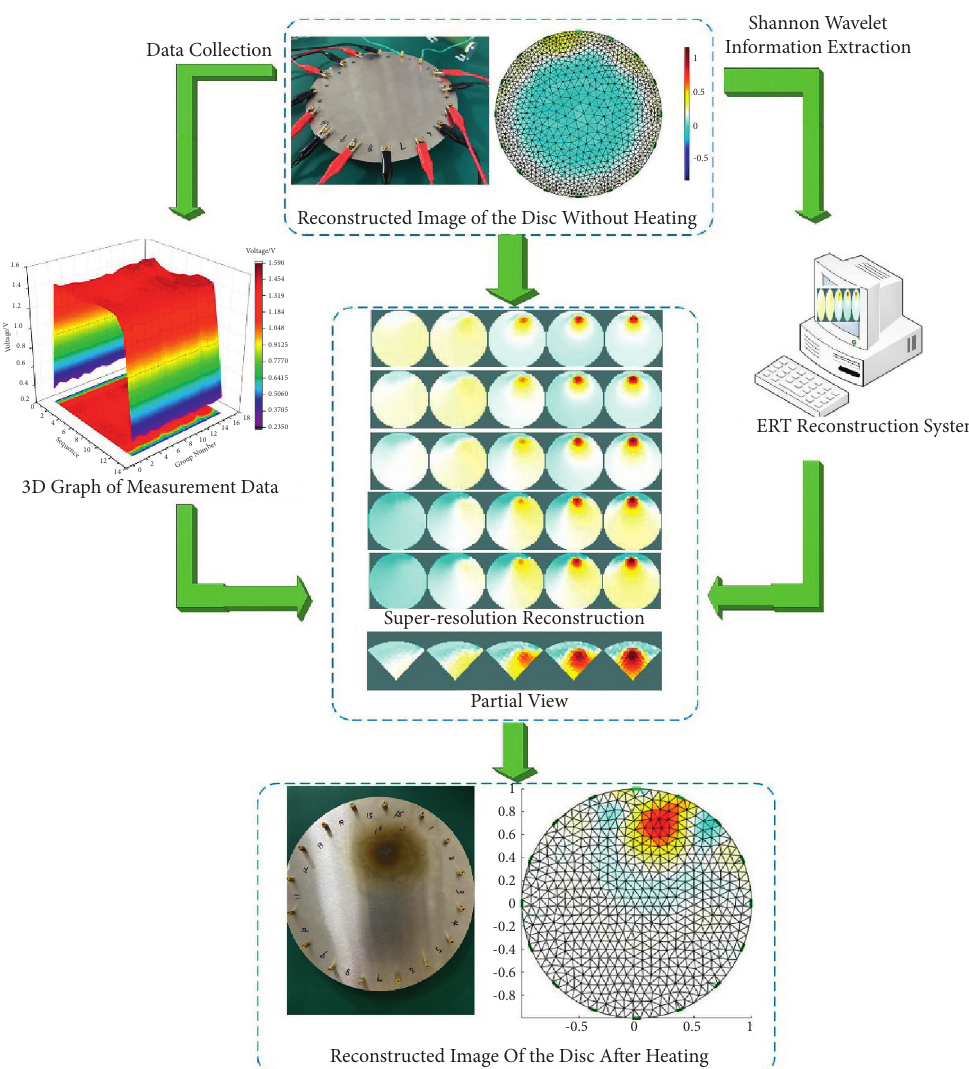
Figure 18: Temperature experiment disc reconstruction diagram.